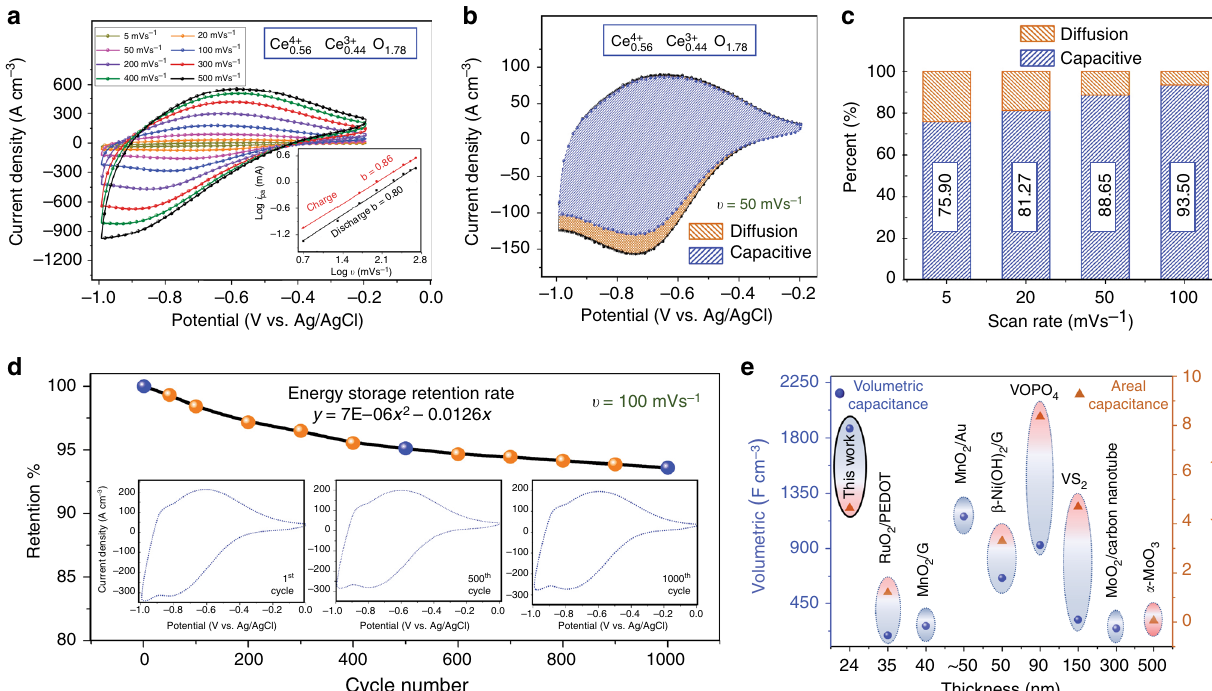
Fig. 3 Pseudocapacitance performance of CeO 2 − x thin fi lms. a Cyclic voltammograms obtained at scan rates in the range 5 – 500 mV s − 1 , plot of log i vs. log ʋ in inset. b Capacitive and diffusional contributions to the total capacitance obtained at a scan rate of 50 mV s -1 . c fractions of capacitive and diffusional contributions at scan rates in the range 5 – 100 mV s -1 . d Stability of charge-storage performance up to 1000 cycles at a scan rate of 100 mV s -1 (inset shows voltammograms obtained at cycle numbers 1, 500 and 1000). e Plot of thickness vs. volumetric and area capacitances obtained in the present work (5 mV s -1 ) compared to data from recently reported works for high-performance materials: ultrathin fi lms of hybrid RuO 2 /PEDOT 55 , MnO 2